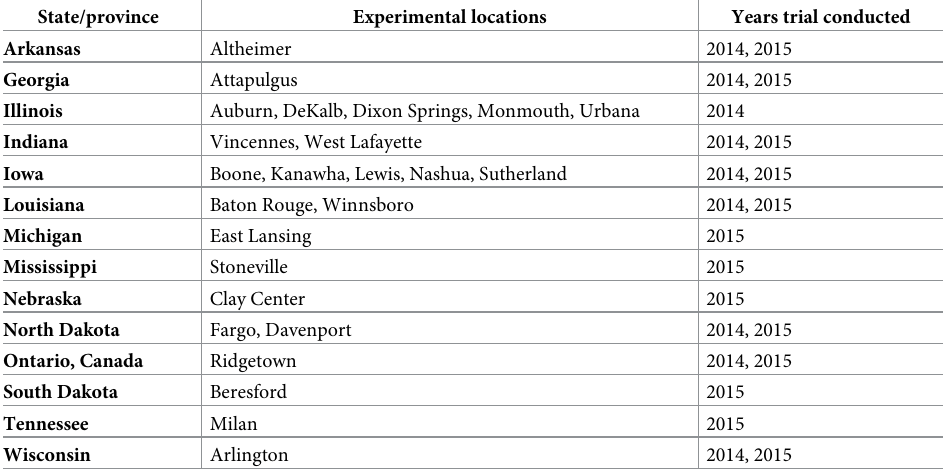
Table 2. Location information for uniform fungicide application timing trials conducted in 2014 and 2015 in the United States and Ontario,